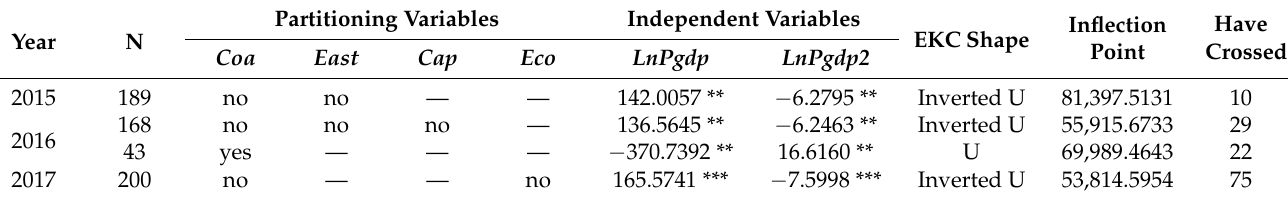
Table A3. Statistical table of environmental Kuznets curve (EKC) inflection point